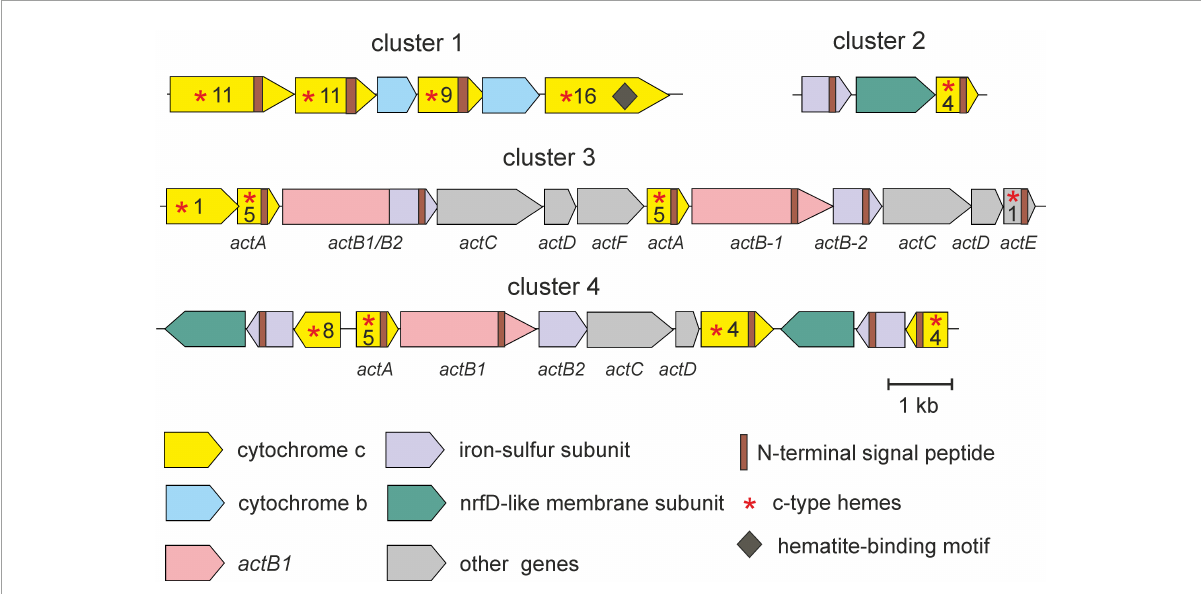
FIGURE4 Clusters of genes possible involved in dissimilatory iron reduction in the SHF-111 bacterium. Genes are represented by arrows. The number of heme-binding motifs (CxxCH) is indicated after the asterisk.